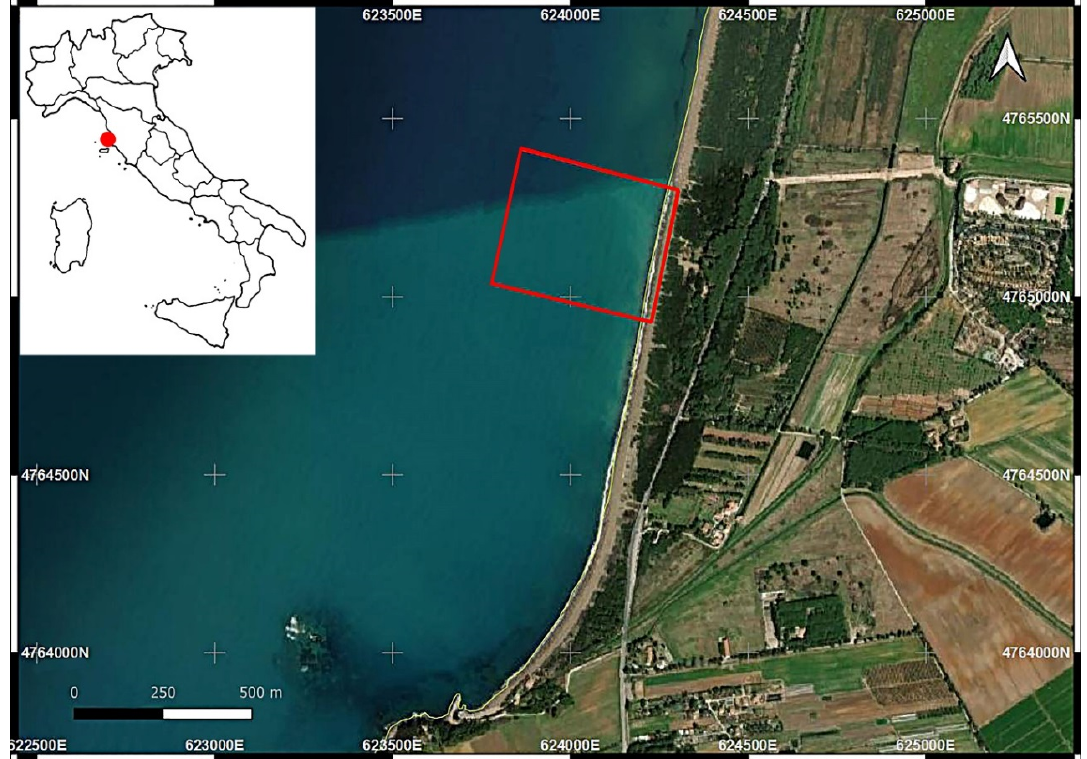
Figure 1. Location map, with the study area being located in the red rectangle.